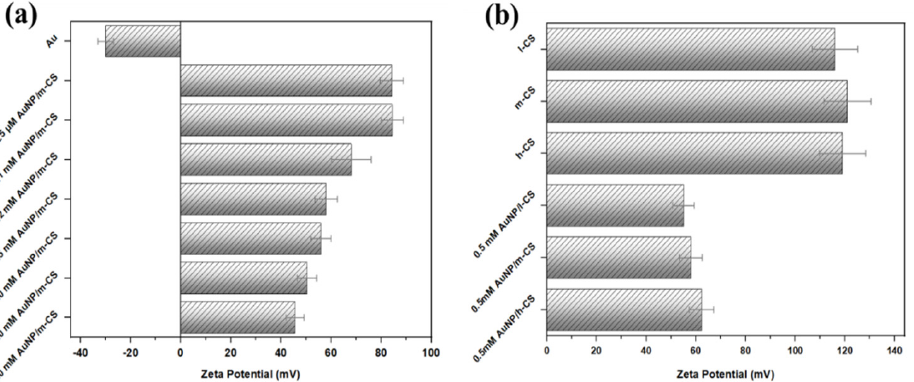
Figure 4. Zeta potential of samples under investigation: ( a ) Au, 2.5 µM AuNP/m-CS, 0.1 mM AuNP/m-CS, 0.2 mM AuNP/m-CS, 0.5 mM AuNP/m-CS, 1.0 mM AuNP/m-CS, 2.0 mM AuNP/m-CS, 4.0 mM AuNP/m-CS, ( b ) l-CS, m-CS, h-CS, 0.5 mM AuNP/l-CS, 0.5 mM AuNP/m-CS, 0.5 mM AuNP/h-CS.